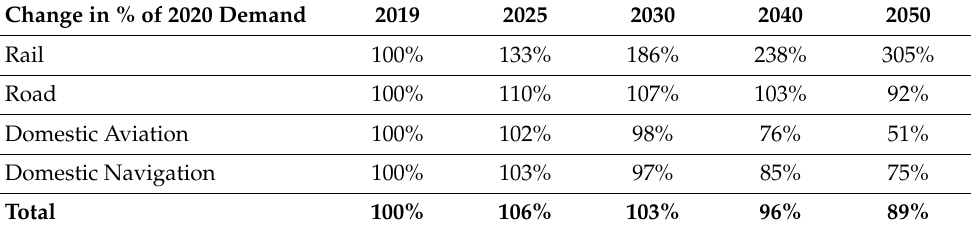
Table 17. Global: Development of changes in freight logistics (based on tkm) by transport